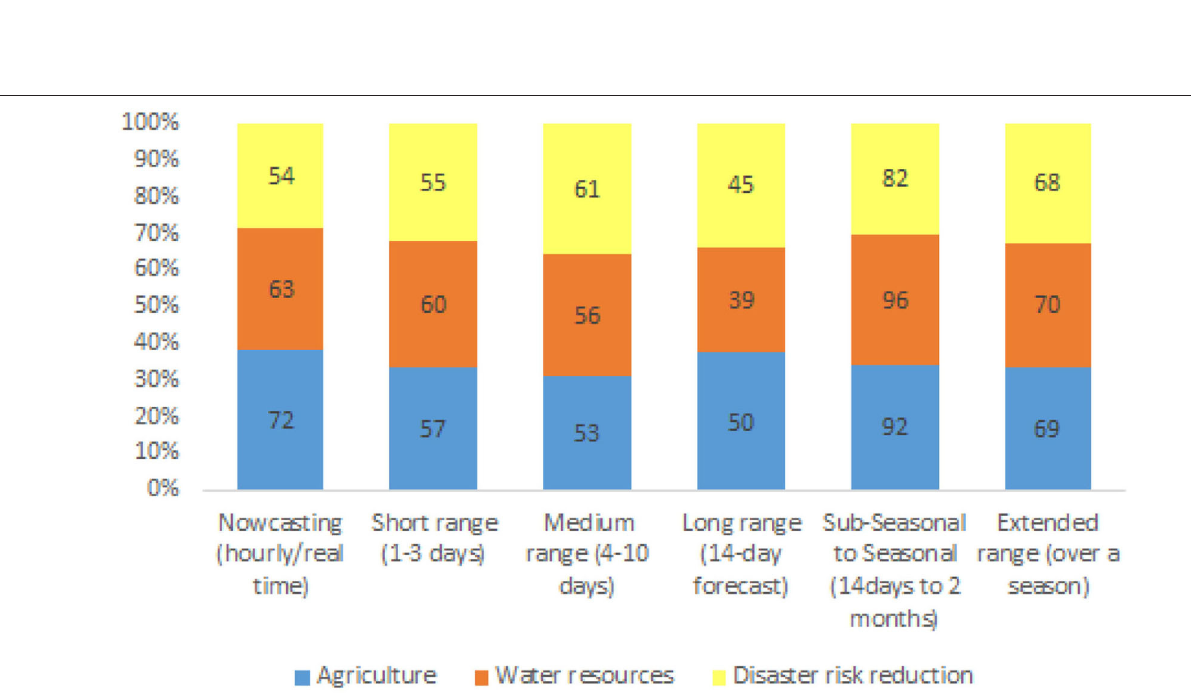
FIGURE 6 | Ranking relative importance of WCI alternatives in disaster risk reduction.